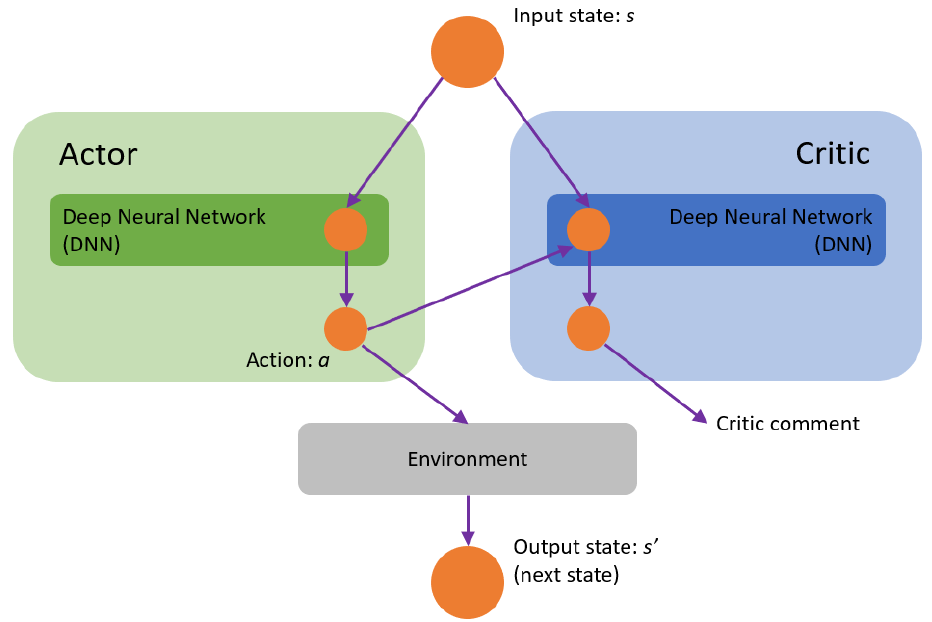
Figure 1. The flowchart of the